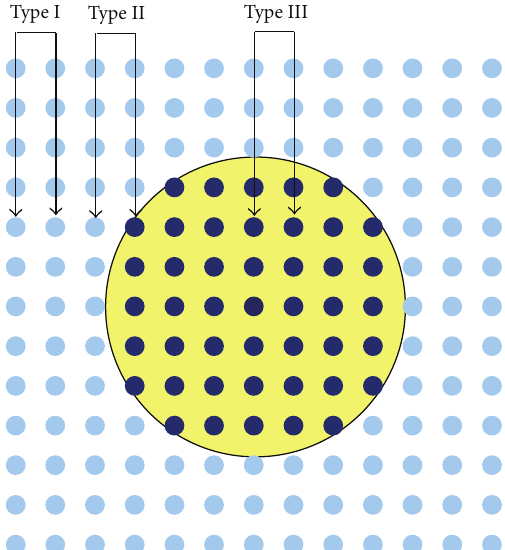
Figure 6: Example of regular grid sampling schema.